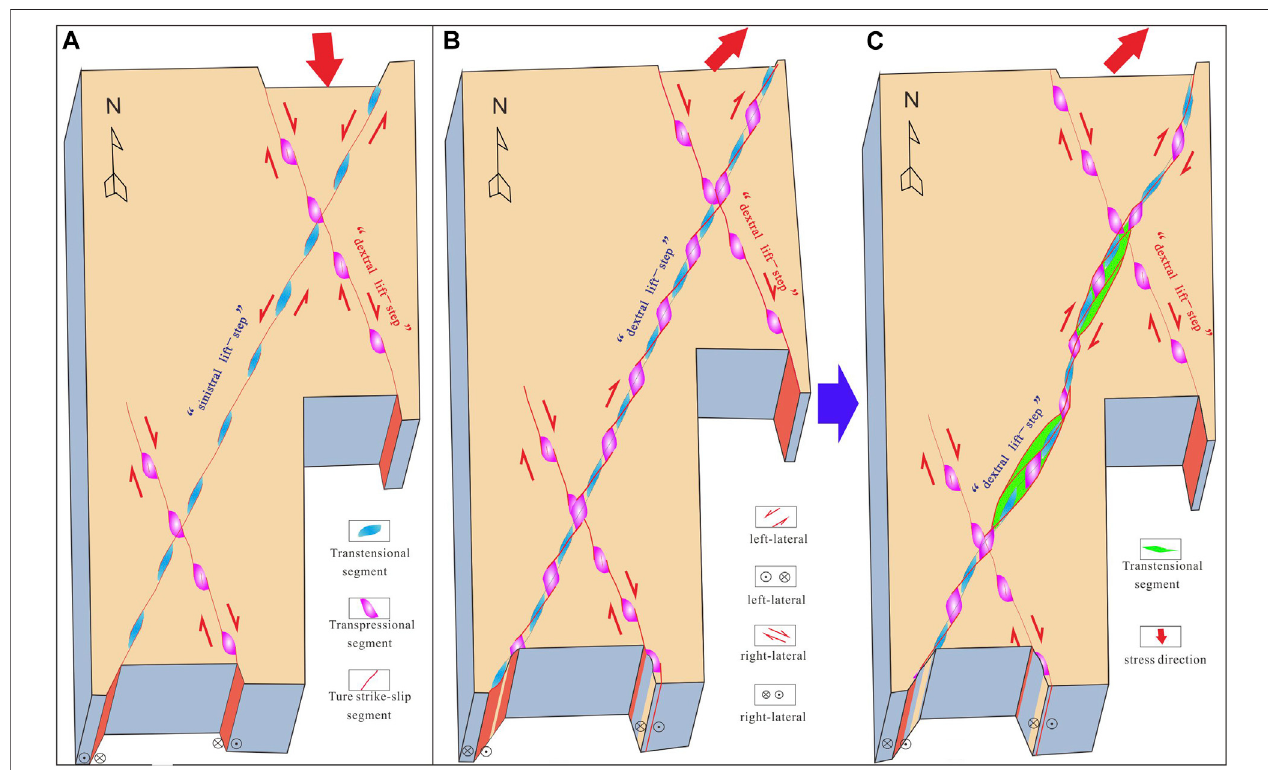
FIGURE 7 | Structural evolution model of Ordovician in key structural period of tp12cx strike slip fault. (A) Middle Caledonian (B) late Caledonian Early Hercynian stage I (C) late Caledonian Early Hercynian stage II.